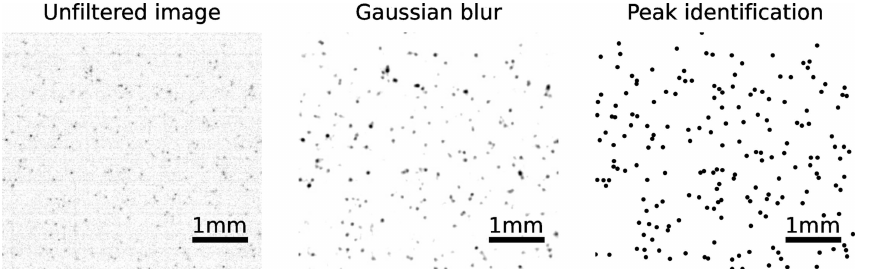
Figure 13 A background-subtracted image (left), a Gaussian filtered image (middle) and the location of identified X-ray photons (right). For better visibility, the colorscale is inverted. The X-ray energy is 40 keV, the scintillator is an 11 m m GOS:Tb screen and the pixel size is 6.5 m